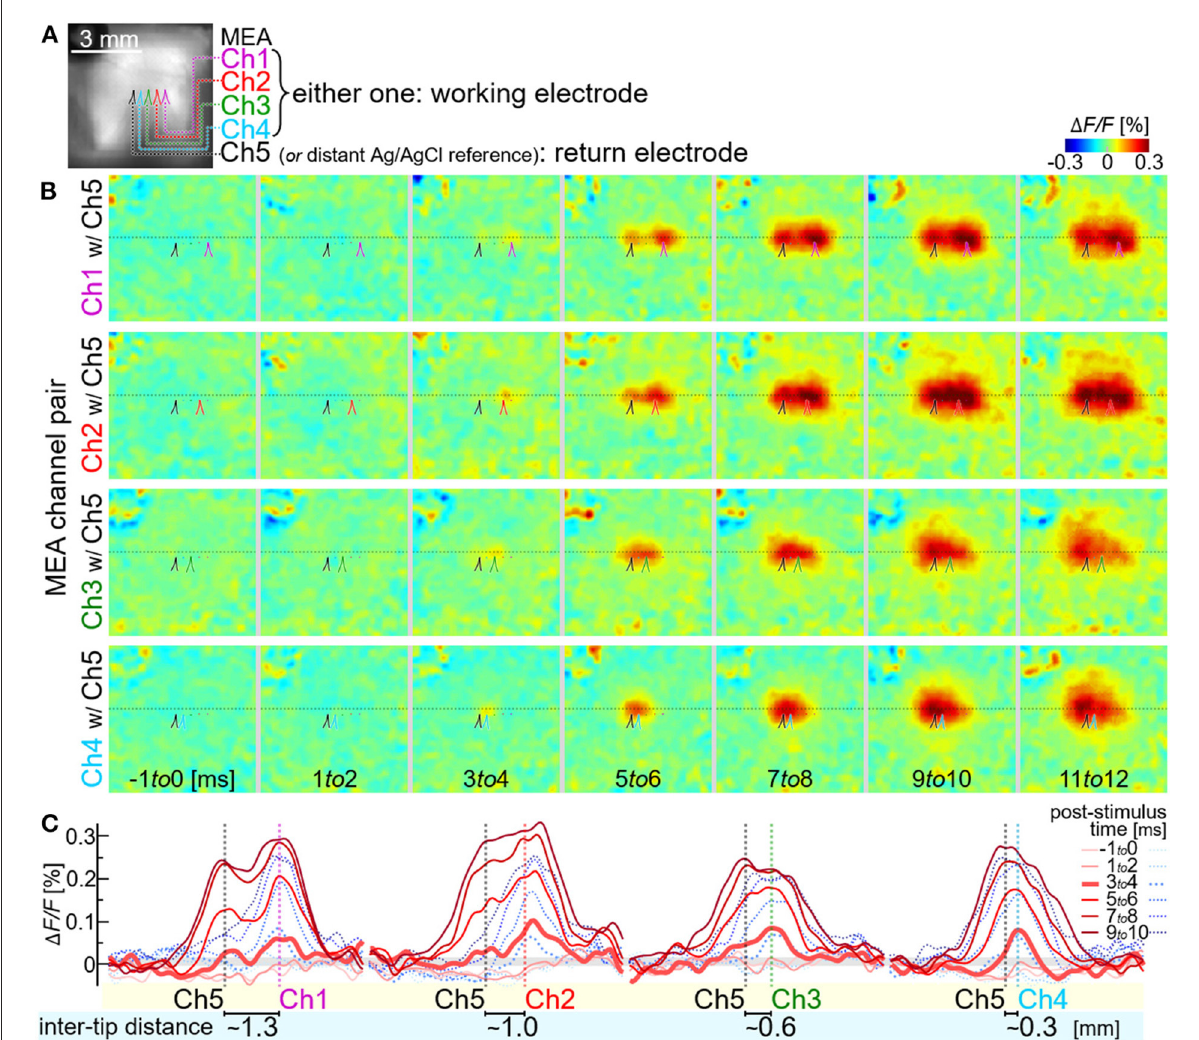
FIGURE9 Neural excitations by the bipolar stimulation with using the stimulation module. (A) VSD fluorescence image of the cortex. Colored lines indicate the outlines of shadows of five stimulating electrode shafts, Ch1-Ch5. (B) Pseudo-color time-lapse 1 F/F images induced by the stimuli with different pairs of the electrodes. (C) Spatial line profiles of the VSD signal along the line in (B) . Red and blue traces indicate the responses to the bipolar and the monopolar stimulations, respectively. Either of the working electrodes, Ch1 to Ch4, and the distant Ag/AgCl reference electrode were used for the monopolar